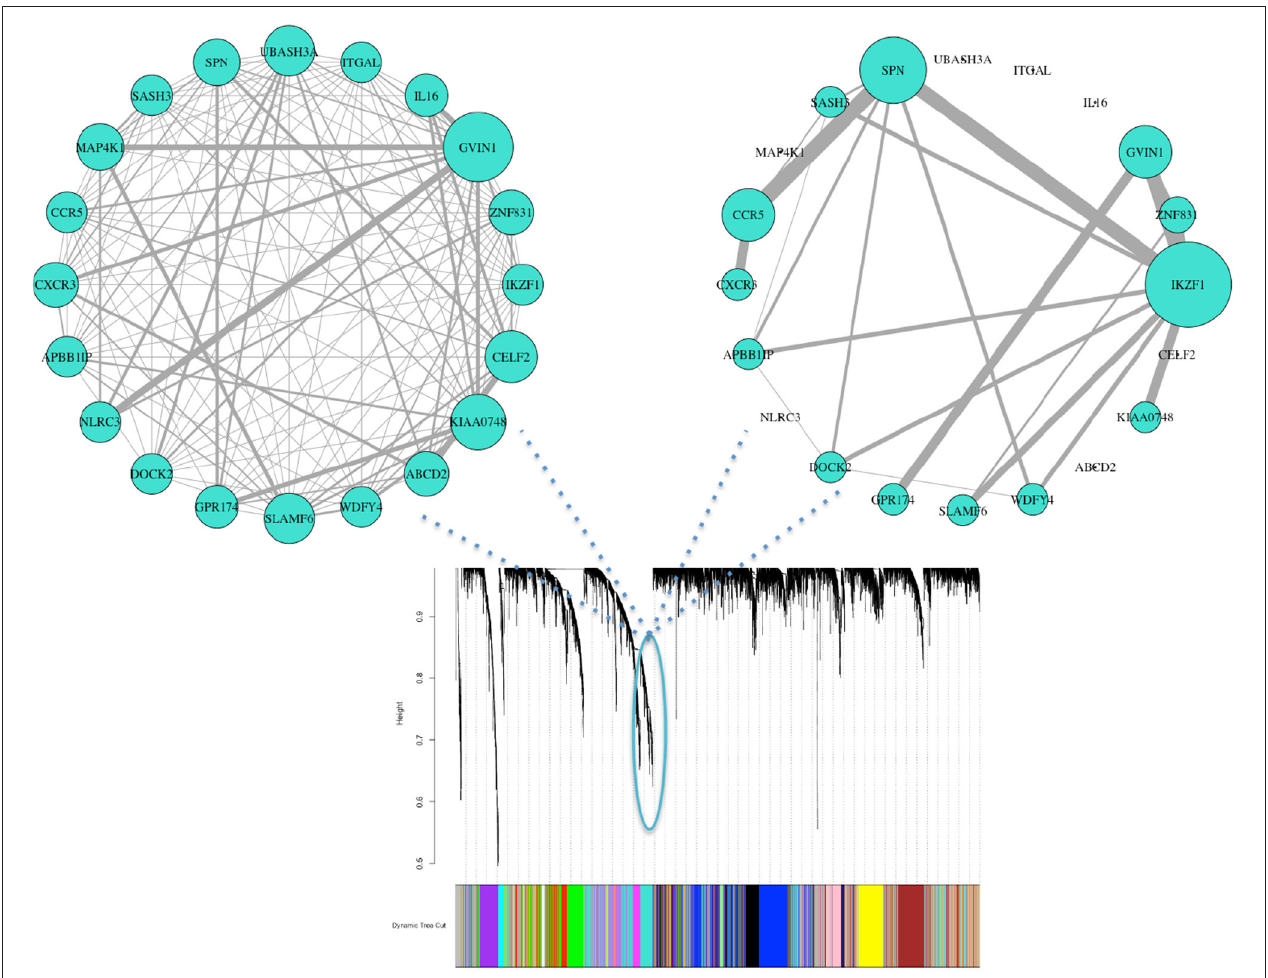
FIGURE 3 | Consensus clustering identifies organized gene expression patterns of both progressor ( left ) and non-progressor ( right ) conditions. These clusters are subnetworks of tightly connected nodes (genes) that we refer to as modules. Here we demonstrate one of the modules color-coded in turquoise, with clear wiring differences/variability (gene effects) between the two conditions. Nodes are the top 20 genes with high kME measure in progressor condition (45% have high kME in non-progressor). Wiring width demonstrates correlation magnitude strength. The networks’ wiring weights are correlations greater than 0.6. Size of each genes node indicates overall connectivity